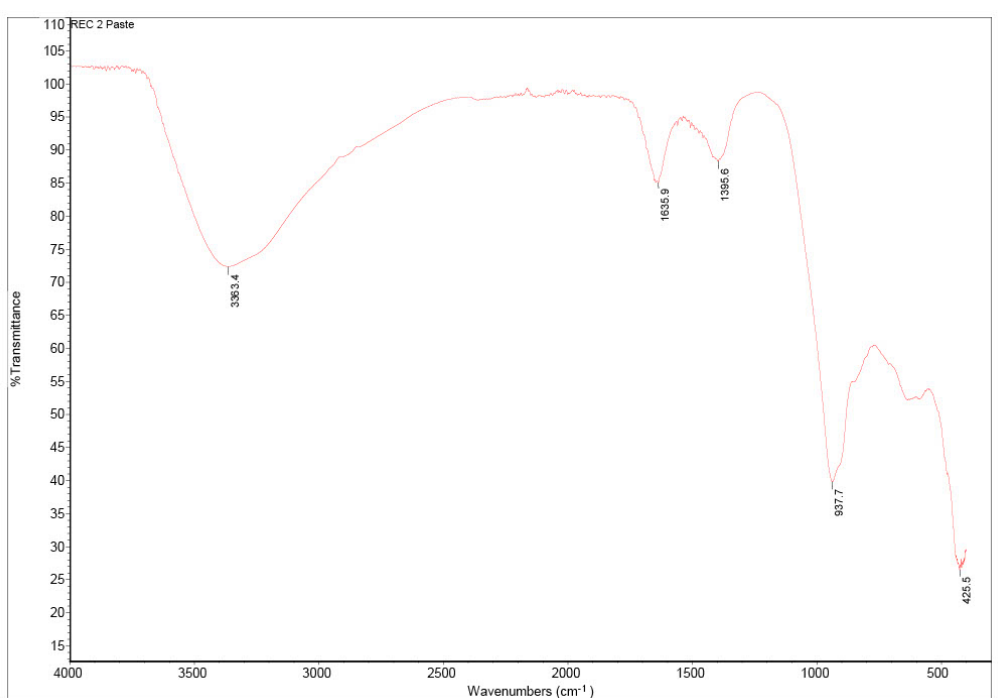
Figure 12. FTIR analysis for REC 2.